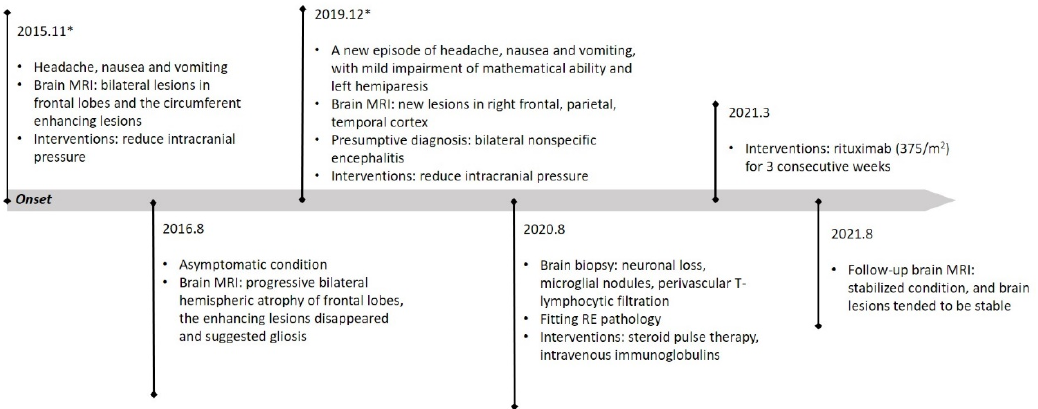
Figure 4. The timeline of the patient with relevant data regarding past episodes and interventions. *: two admissions.